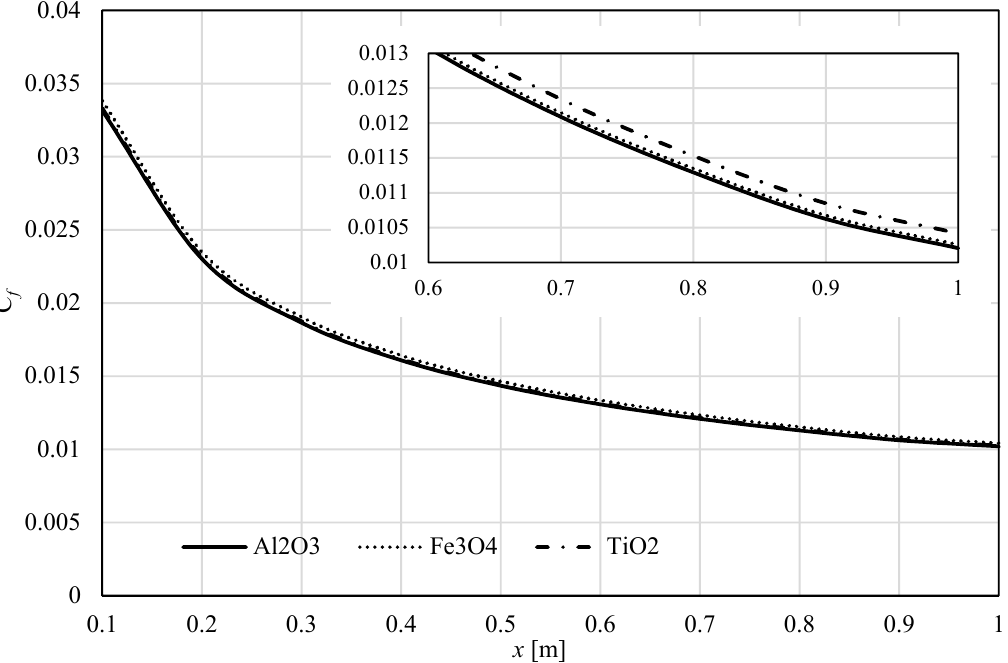
Figure 10. The skin friction (𝐶 (cid:3033) ) along the sheet for all three nanofluids ( 𝜙 = 0.04) .